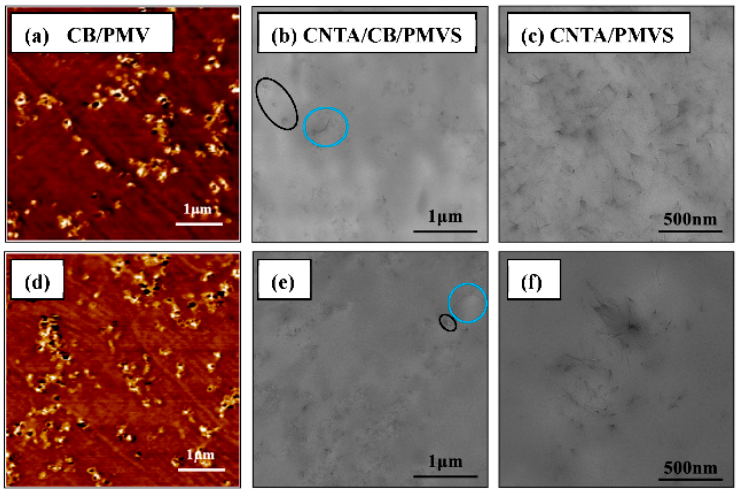
Figure 7. ( a ), ( d ) AFM adhesion micrographs of CB/PMVS composites with 1.5 vol % of CB; ( b ), ( e ) TEM micrographs of the composites with 1.5 vol % of CNTA and CB; ( c ), ( f ) TEM micrographs of the